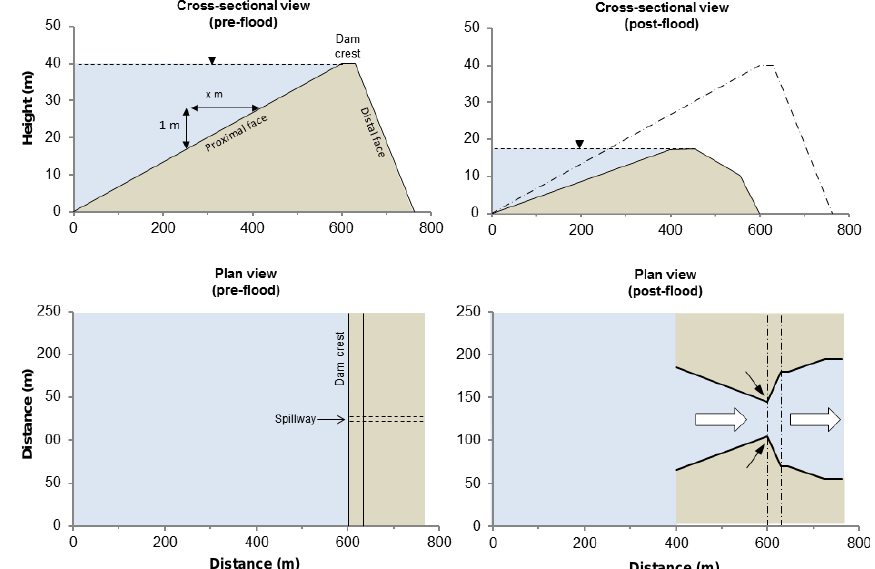
Figure 3. Schematic diagrams of initial (pre-flood) and an example of post-flood geometry for the Dig Tsho moraine dam (left and right columns, respectively), as modelled by HR BREACH. Initial dam face slope angle is represented as a ratio of the form 1: x . White arrows indicate flow direction. Solid black arrows (post-flood, plan view panel) highlight location of the critical flow constriction and used as a likelihood measure for model evaluation. Note vertical exaggeration of dam